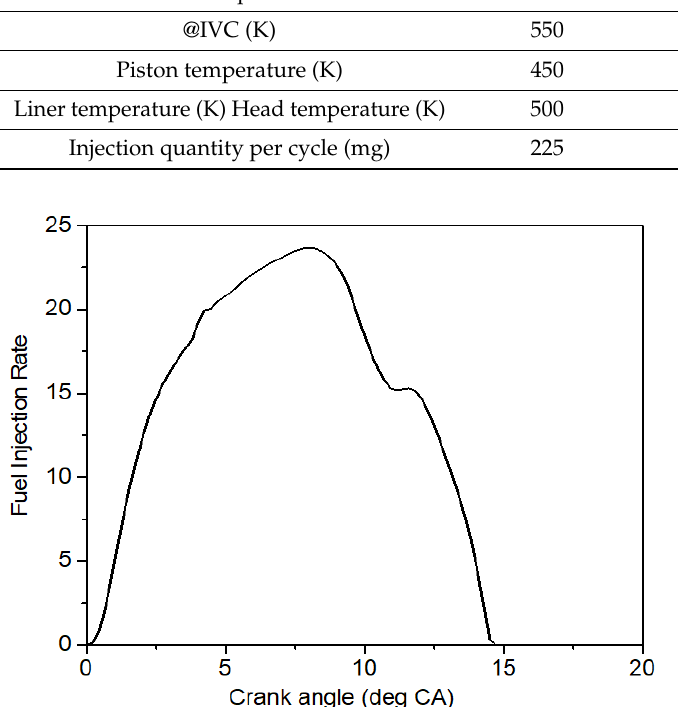
Figure 3. Profile of fuel injection